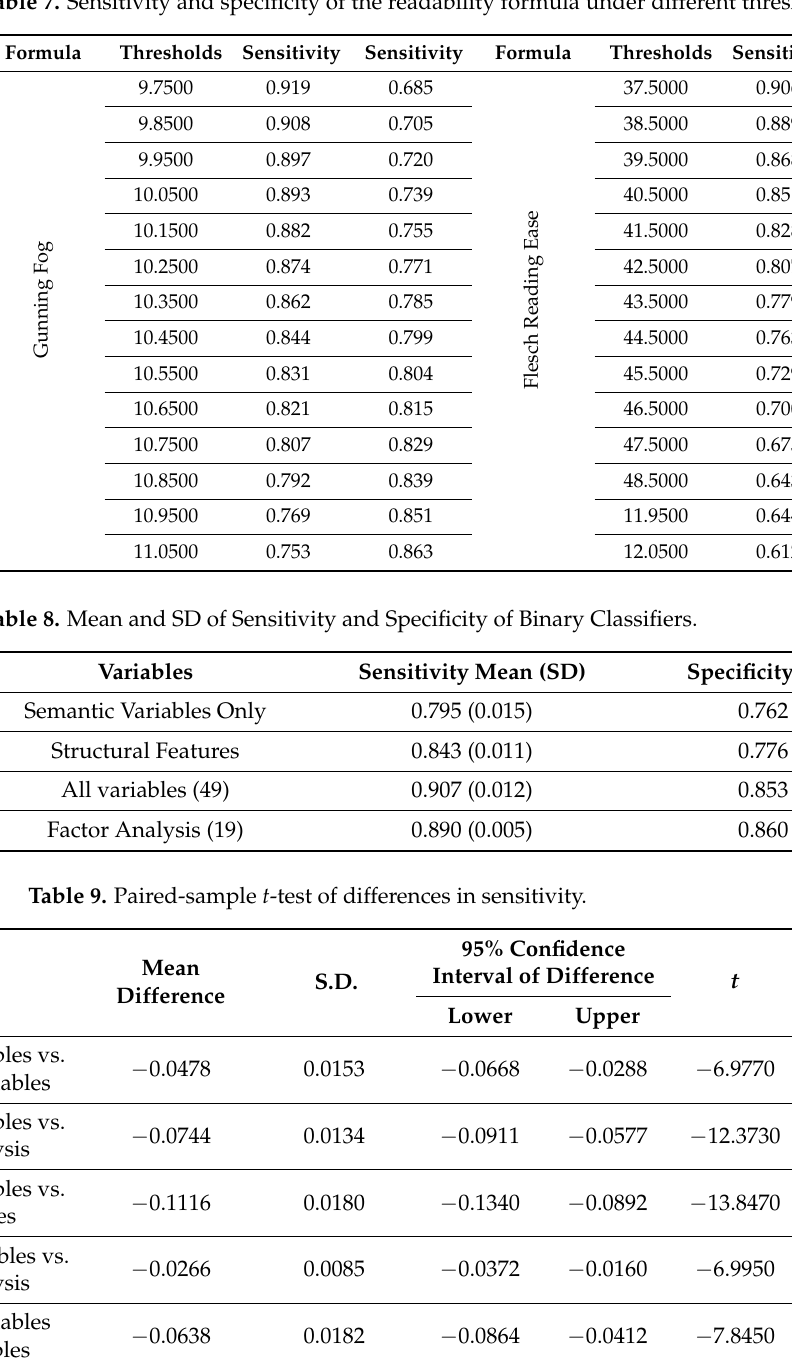
Table 7. Sensitivity and specificity of the readability formula under different thresholds.